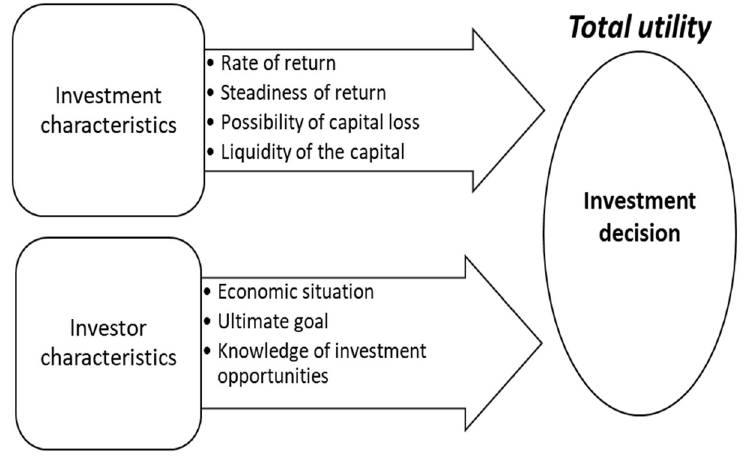
Figure 1. Total utility expected to be achieved from an investment option.